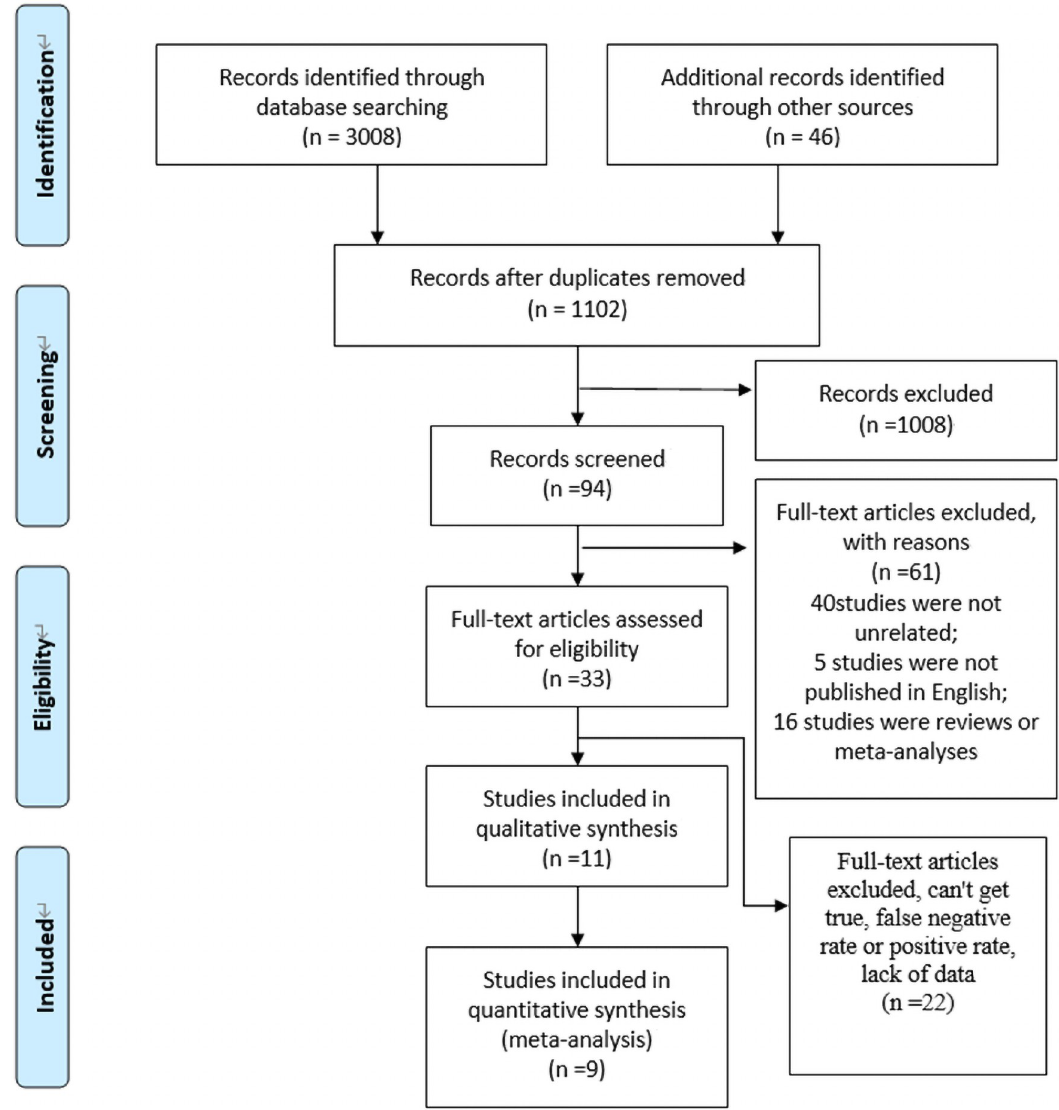
Fig 1. Retrieval process and selection